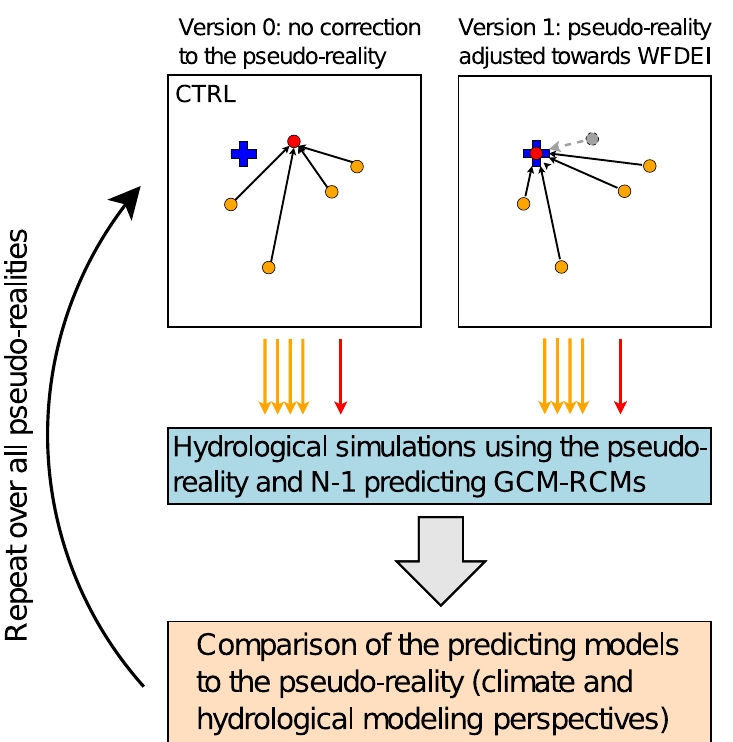
Figure 4. An illustration of the pseudo-reality framework procedures in the baseline period, applied both from climate modeling and hydrological modeling